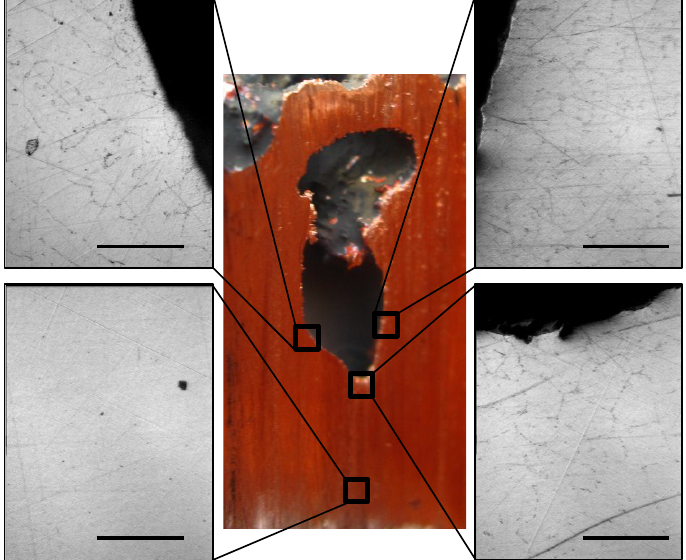
Figure 5. Photograph of a cross section of a M0 copper ingot from the “closed” gas flow configuration in which a void was found near the center of the upper surface of the ingot. The top of the image is the top surface of the sample. Optical microscopy images (100×, scale bars = 425 µm) obtained from various regions of the sample are shown in the insets and reveal the copper oxide distribution within the